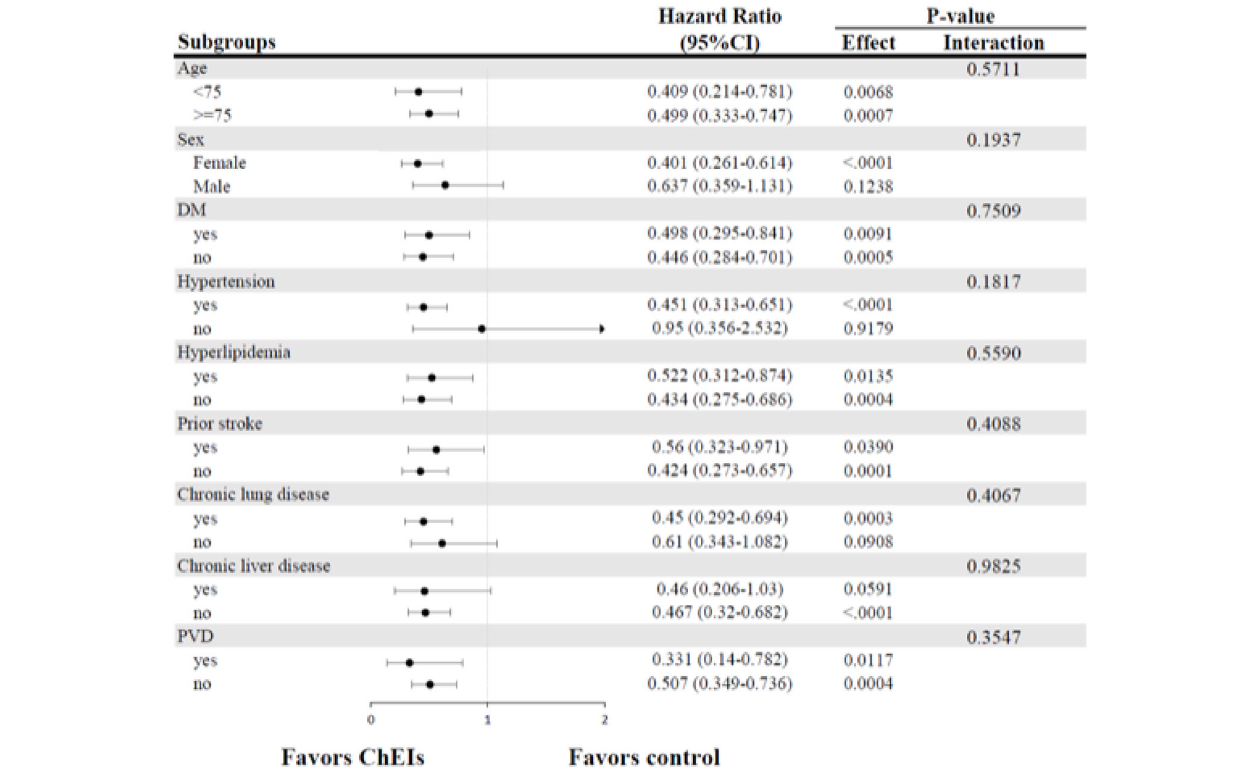
FIGURE 3 | Forest plots of subgroup analysis for new-onset HF. CI, confidence intervals; DM, diabetes mellitus; HF, heart failure; PVD, peripheral vascular